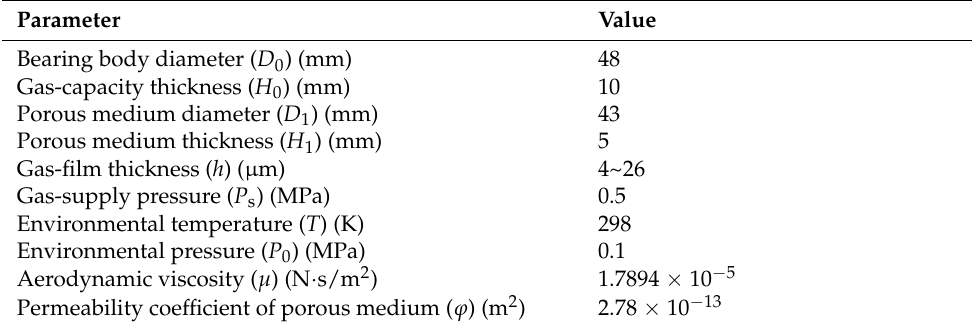
Table 2. The parameters of the aerostatic bearing.